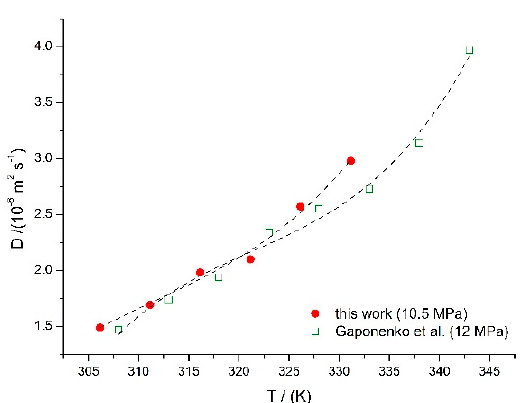
Figure 5. Diffusion coefficient for ethanol in scCO 2 and comparison with literature data [42].